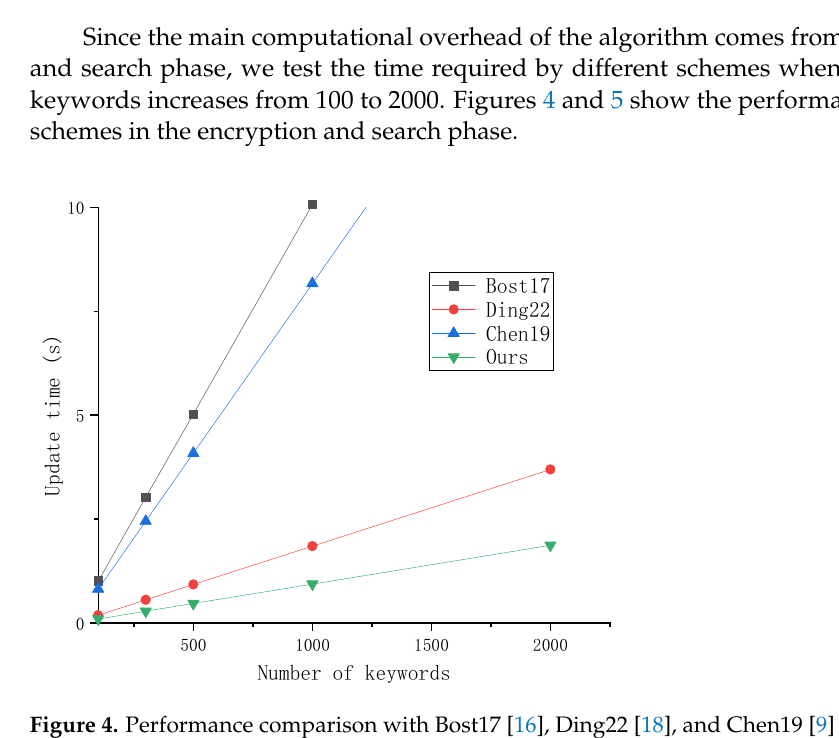
Figure 4. Performance comparison with Bost17 [16], Ding22 [18], and Chen19 [9] in the encryption and update phase.